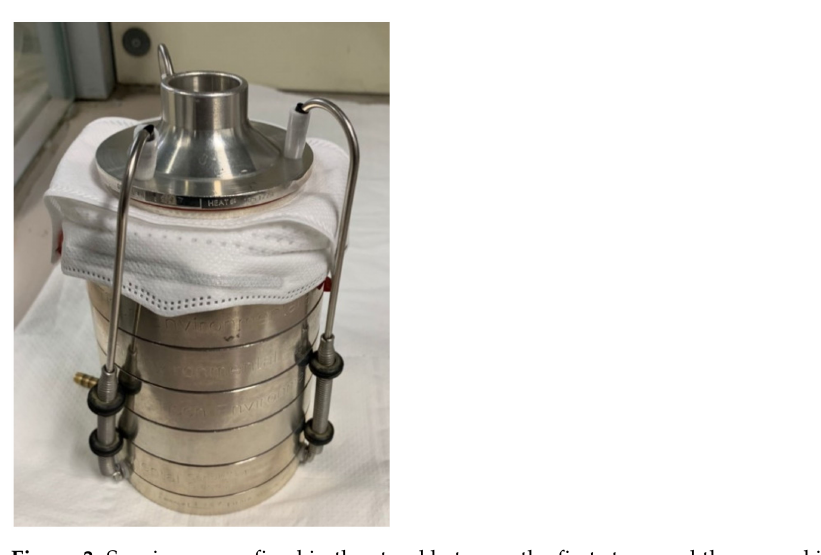
Figure 3. Specimens are fixed in the stand between the first stage and the aerosol inlet